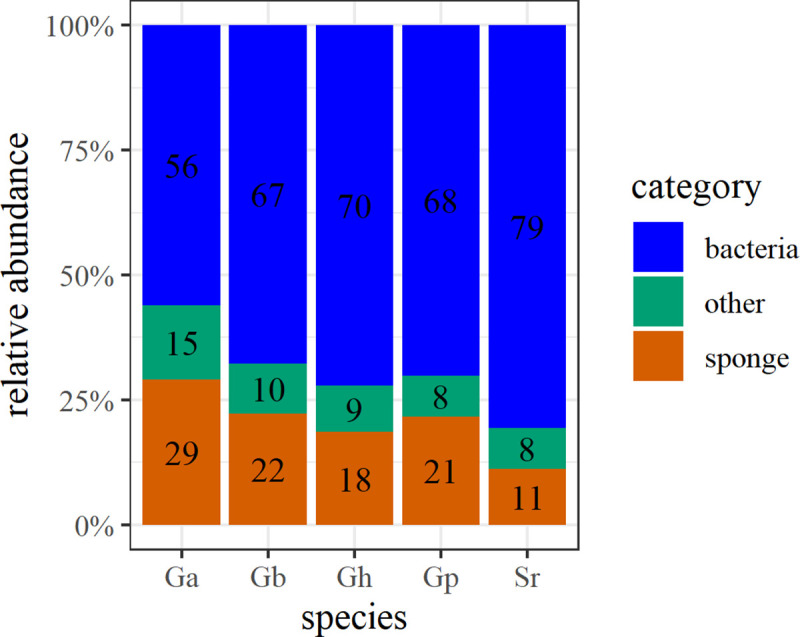
Average contribution of bacterial FAs (blue), sponge LCFAs (orange) and other FAs (green) to the total PLFAs of each species (abbreviated as in Table 1).